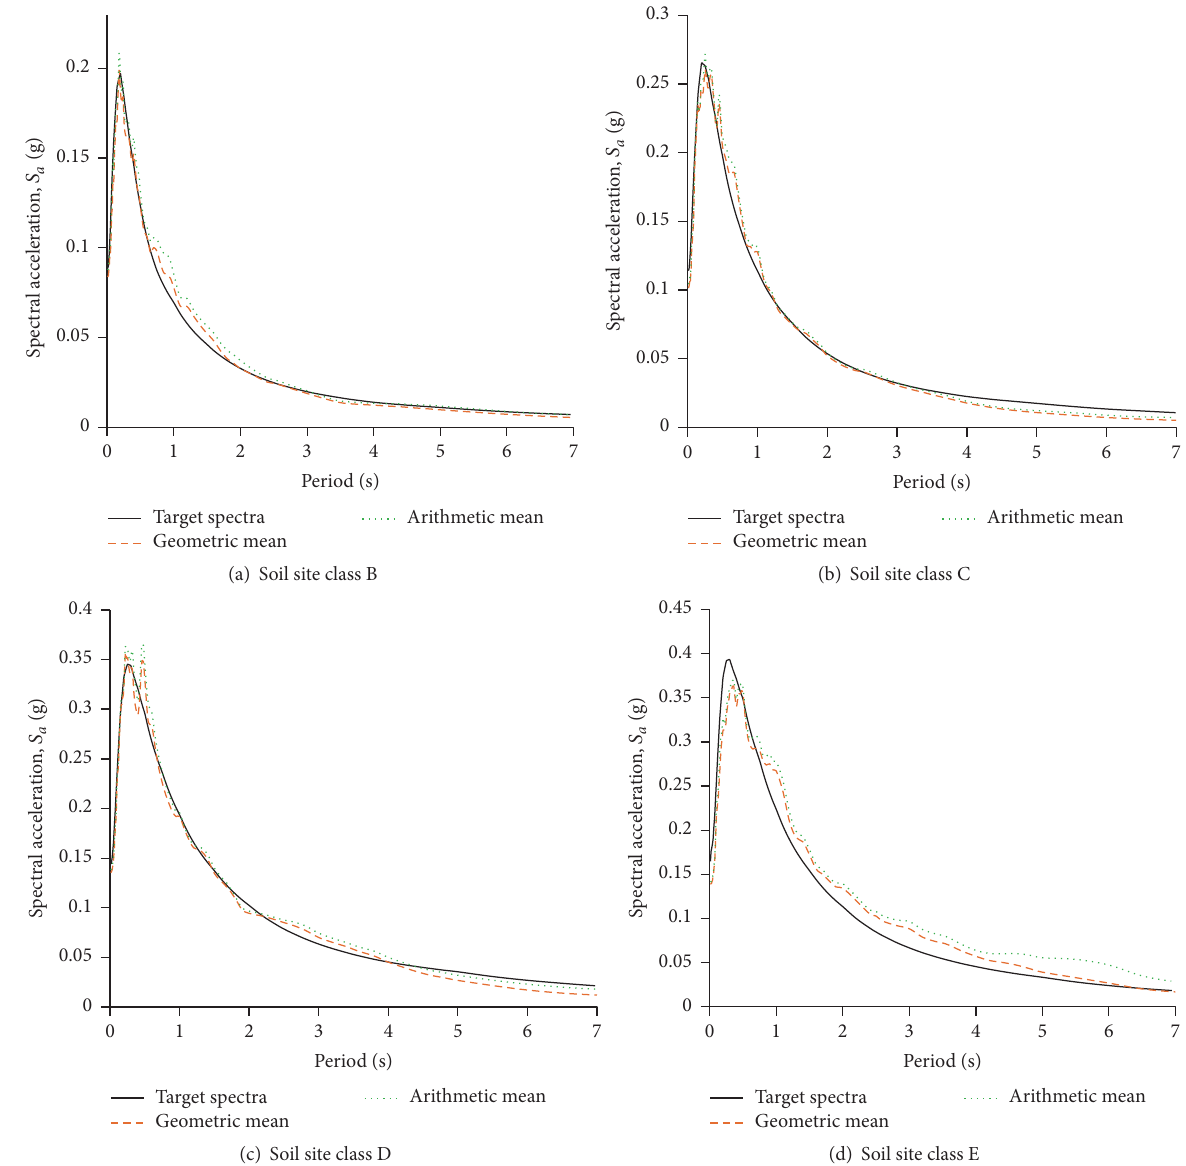
Figure 2: Target and mean spectra for different soil site